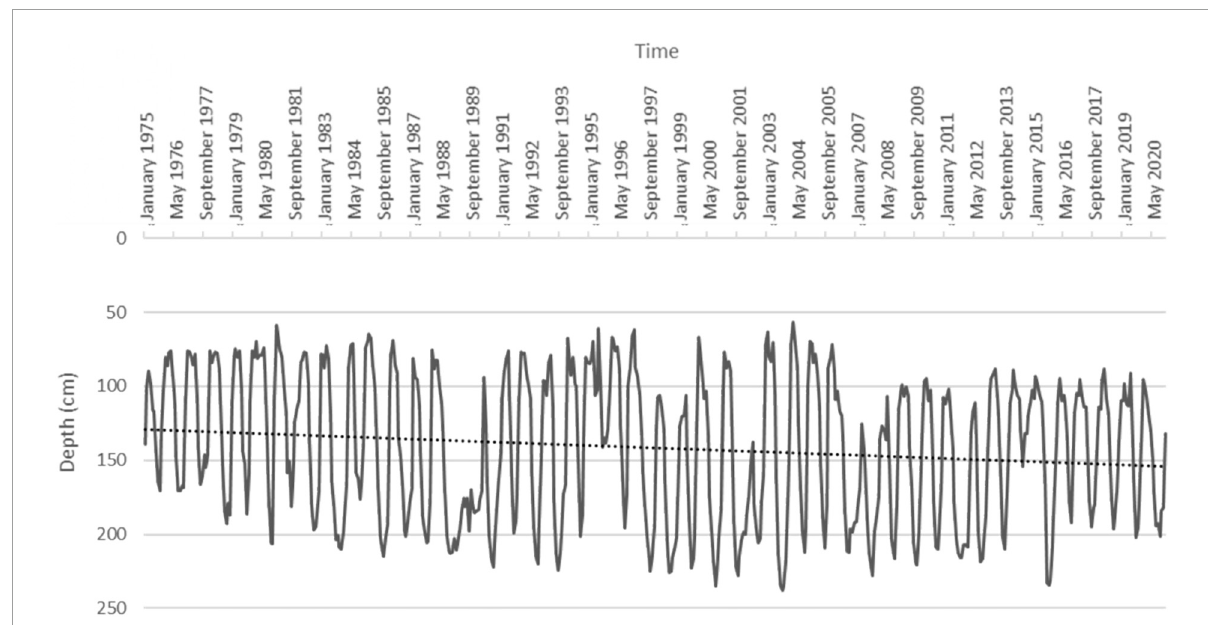
FIGURE4 Water table depth in Cadriano from 1975 to 2020. The dashed line represents the increasing depth trend (significant to the Mann-Kendall test).